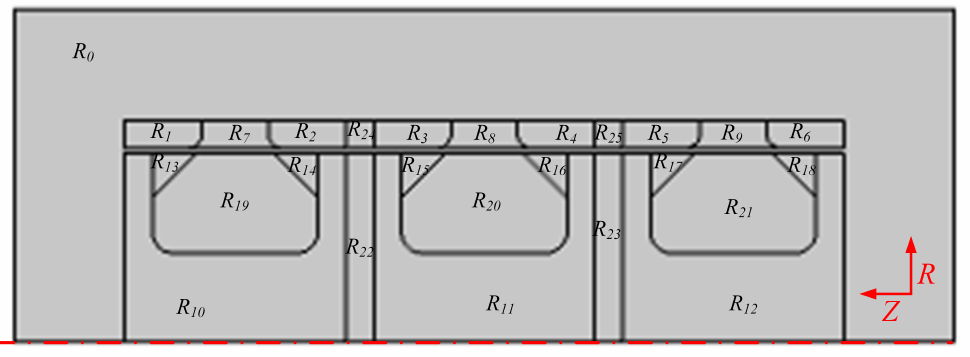
Figure 5. Two-dimensional axisymmetric model of the proposed